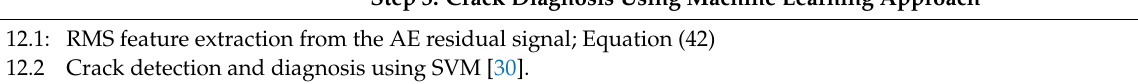
Figure 8. Error of AE signal modeling using ALS, GL and proposed ALSGL approaches. Figure 9 shows the residual signal based on the proposed digital twin (PDT). The visibility of the PDT was perfect for classifying the bearing conditions. Based on this fig- ure, the residual signal had 120,000 samples and had 8 different conditions, including HC, BC, IC, OC, IBC, OBC, IOC and IOBC. The minimum residual signal was for the healthy condition. Because the signal was modeled for this condition and we had the best estima- tion accuracy, the residual signal was minimum in this condition.